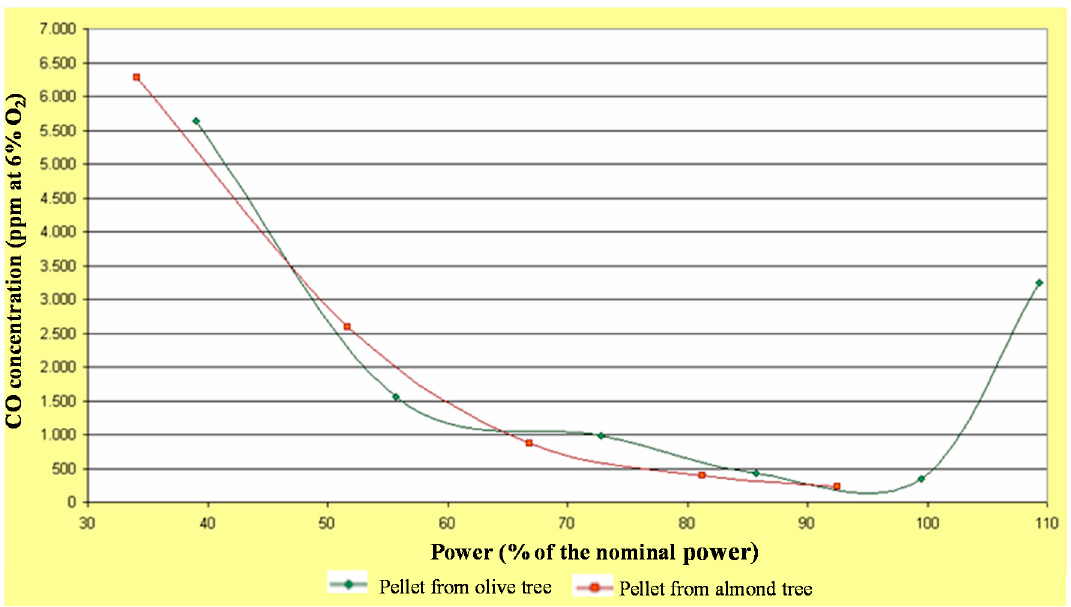
Figure 3. Evolution of CO emissions corrected to 6% O 2 depending on the partial operating load during combustion tests with pellets from almond and olive trees.